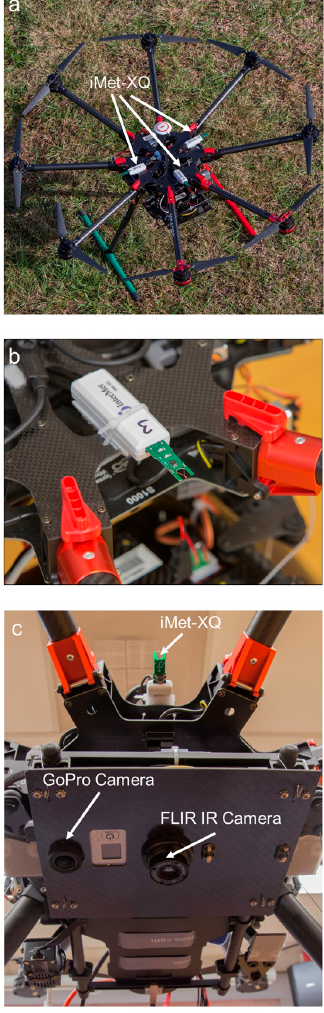
Figure 1. Sensor mounting locations of the iMet-XQ, FLIR infrared camera, and GoPro camera on the DJI S-1000. Panel ( a ) shows the position of three iMet-XQ sensors on board the sUAS prior to flight, panel ( b ) shows a closeup of one of the iMet-XQ sensors, and panel ( c ) shows the location of one iMet-XQ sensor relative to the GoPro and FLIR infrared cameras.